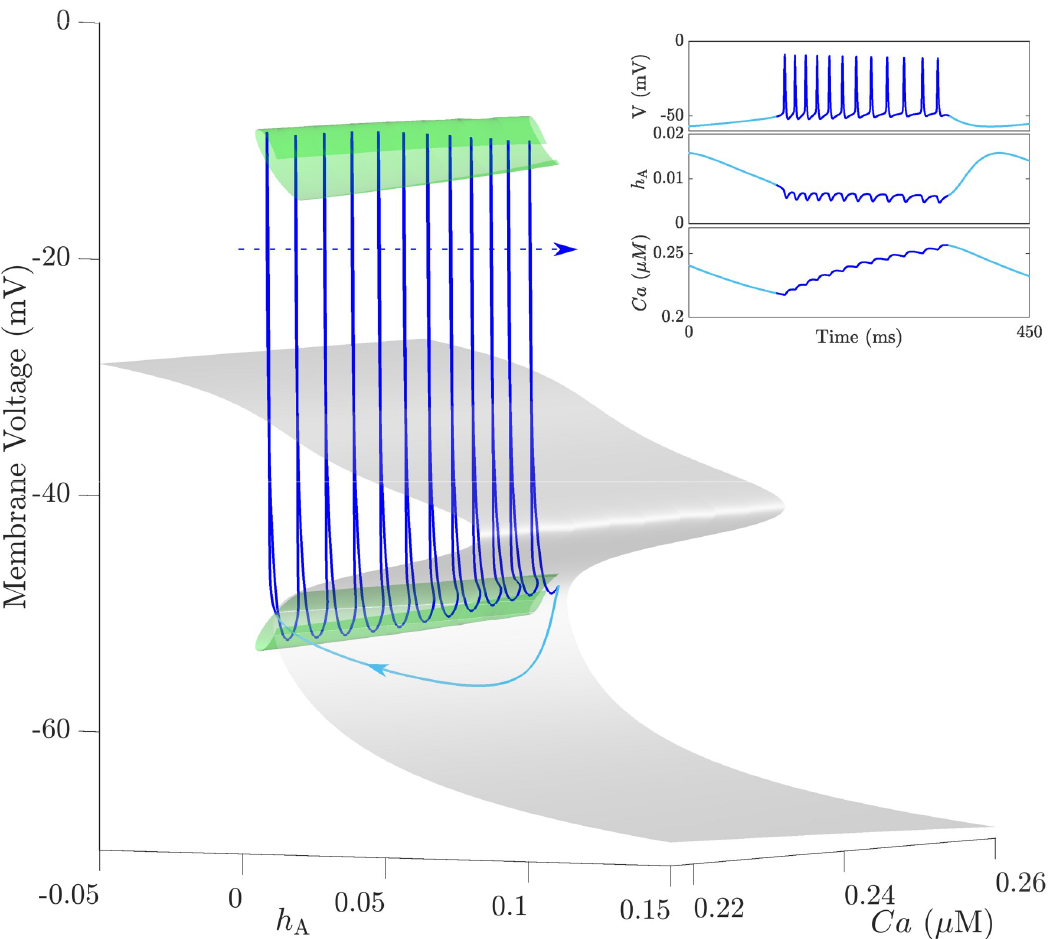
Fig 11. A three-dimensional representation of the bifurcation diagram shown in Fig 10 for a whole range of [Ca 2+ ] i ( Ca ). The gray surface is the critical manifold with three sheets of equilibria separated by two folds, whereas the green surface is a family of isolated envelopes of periodic orbits (as suggested by Fig 10). The lower/middle sheets of the critical manifold are attracting/ repelling, respectively, while the upper sheet is attracting to the left of a curve of Hopf bifurcations (not shown), and repelling to the right. The sheets of unstable periodic orbits emanating from the curve of Hopf bifurcations are not shown. A square-wave bursting trajectory (blue) is superimposed on the bifurcation diagram. The arrows indicate the direction of flow and dark and light shades of blue discern between active and silent phases of the BPO, respectively. The inset shows the time courses of V , h A and Ca corresponding to the square-wave BPO shown in the main panel.